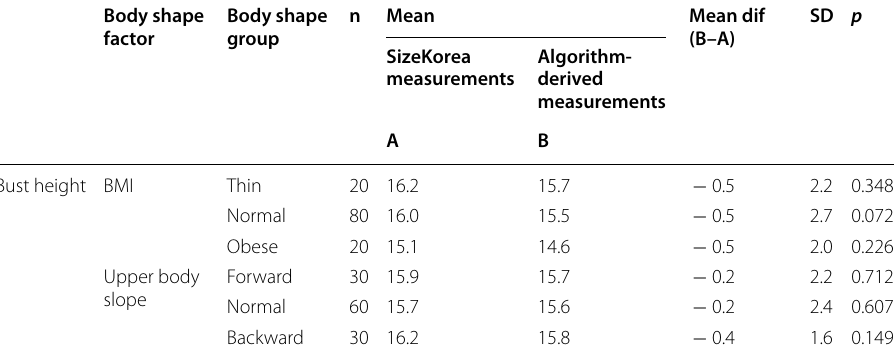
Table 10 The t -test results of the bust height